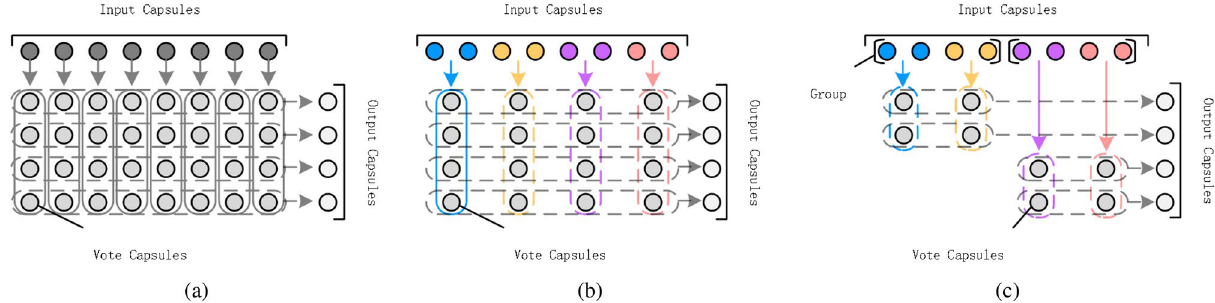
Figure 1. Demonstration of capsules forwarding between layers. ( a ) Each input capsule produces a vote capsule for output capsule. ( b ) Trainable weight matrics are shared within local spatial kernel of the same type capsules. Thus, the capsules in the same type only produce one capsule for each output capsule. ( c ) Grouped